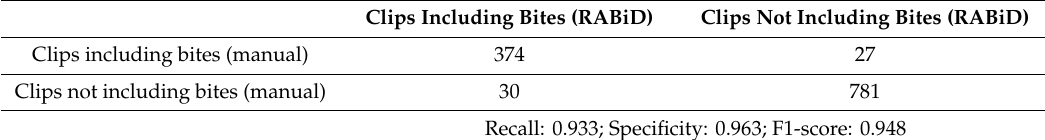
Table 3. Confusion matrix, recall, specificity, and F1-score of the RABiD algorithm performance in the evaluation subsample of video clips in the TD ( n = 1212).